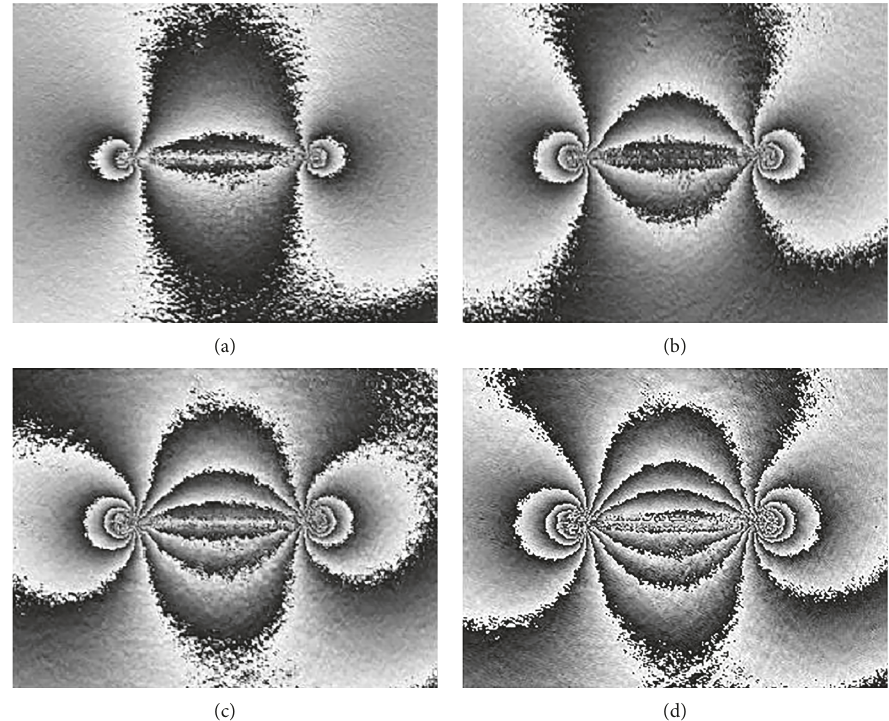
Figure 3: The wrapped phase of the object wave through the PMMA specimen with a crack. (a) σ 2MPa, and (d) σ 00 2.5 MPa. (c) σ 00 (cid:29) (cid:29)